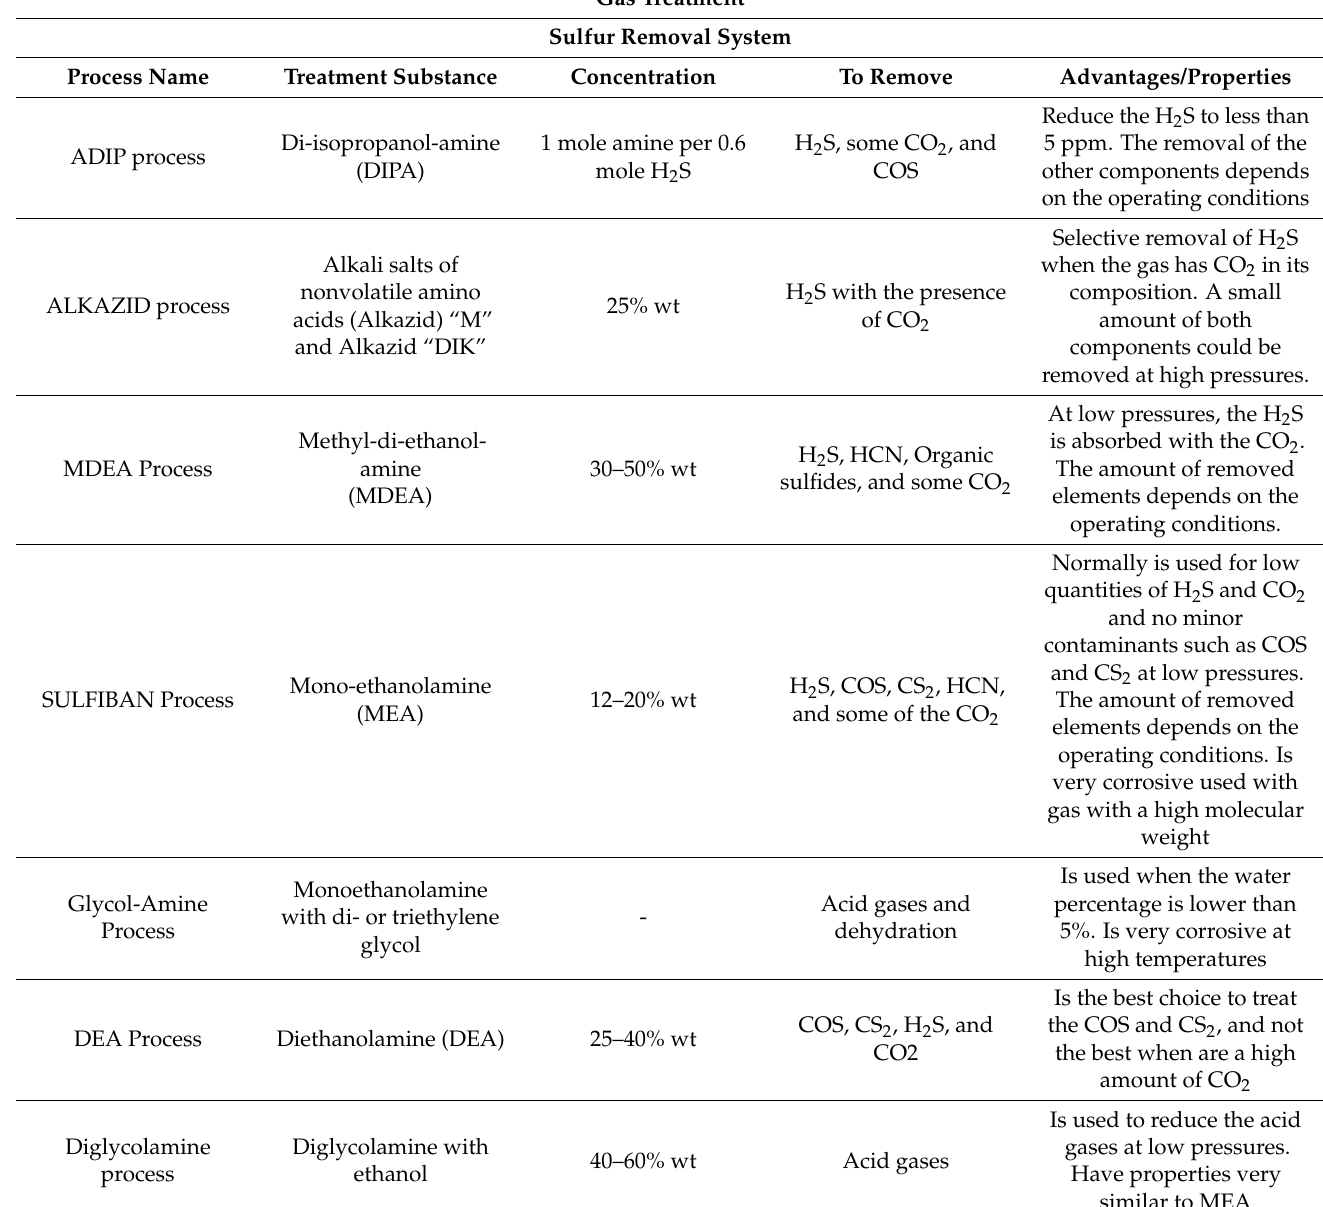
Table 5. Gas treatment and the sulfur removal systems